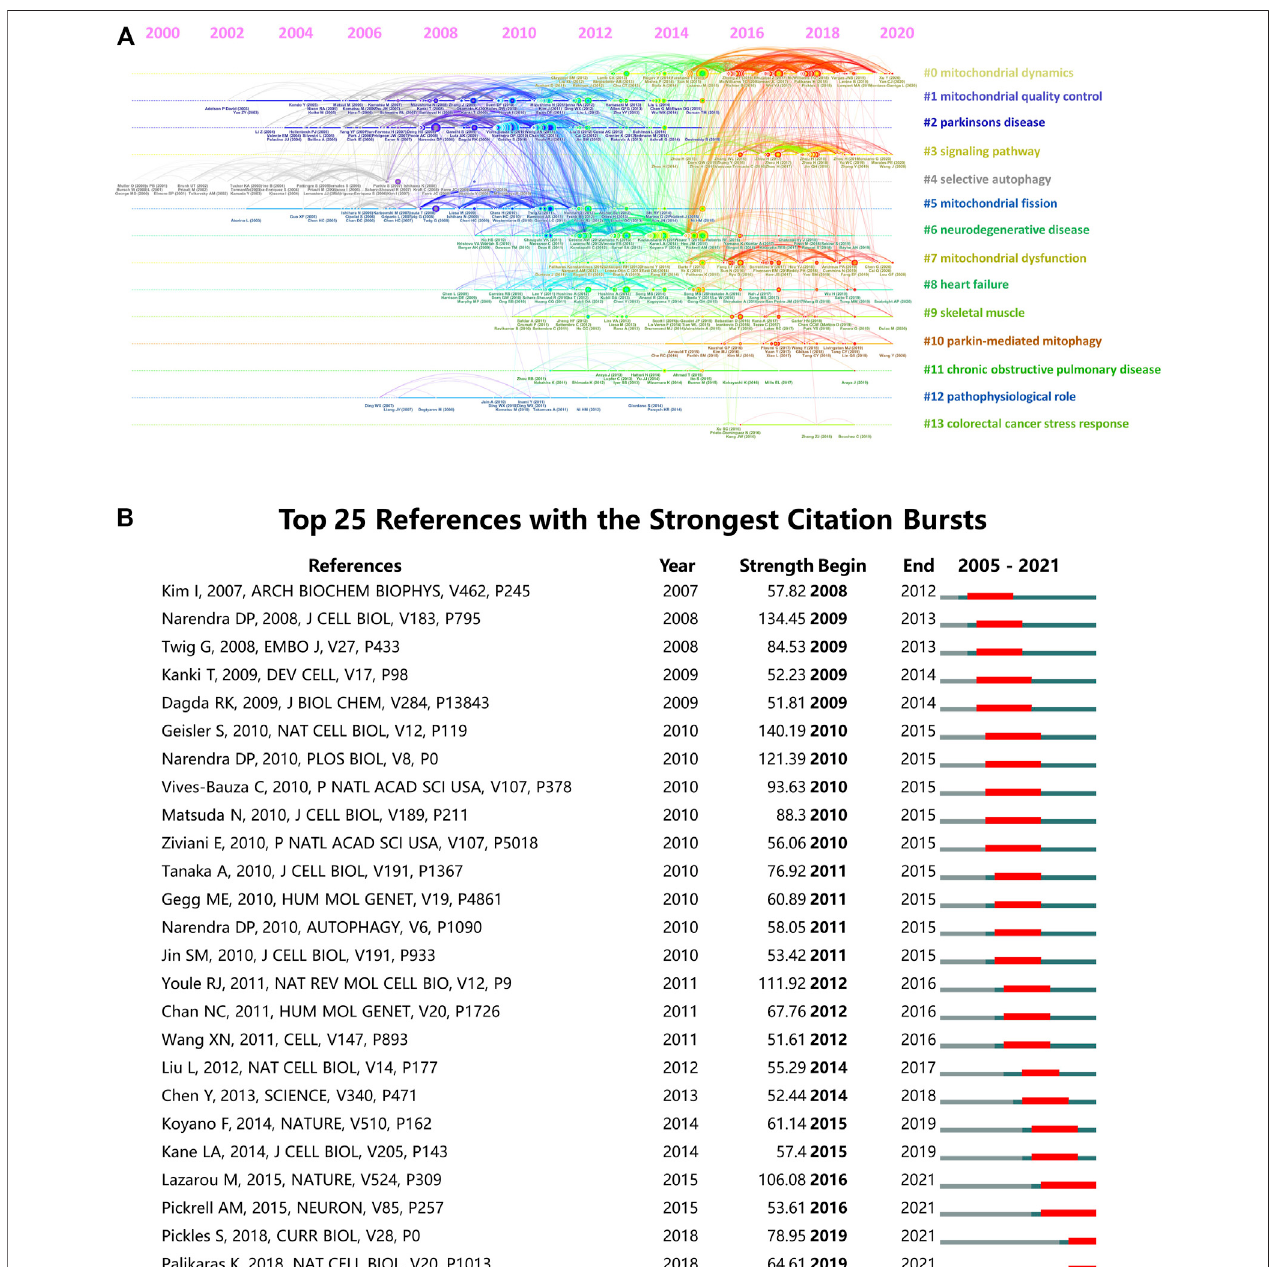
FIGURE7| Analysisofco-citedreferencesofthe5844articlesonmitophagy. (A) Timelineviewofco-citedreferences. (B) Top25referenceswithstrongestcitation